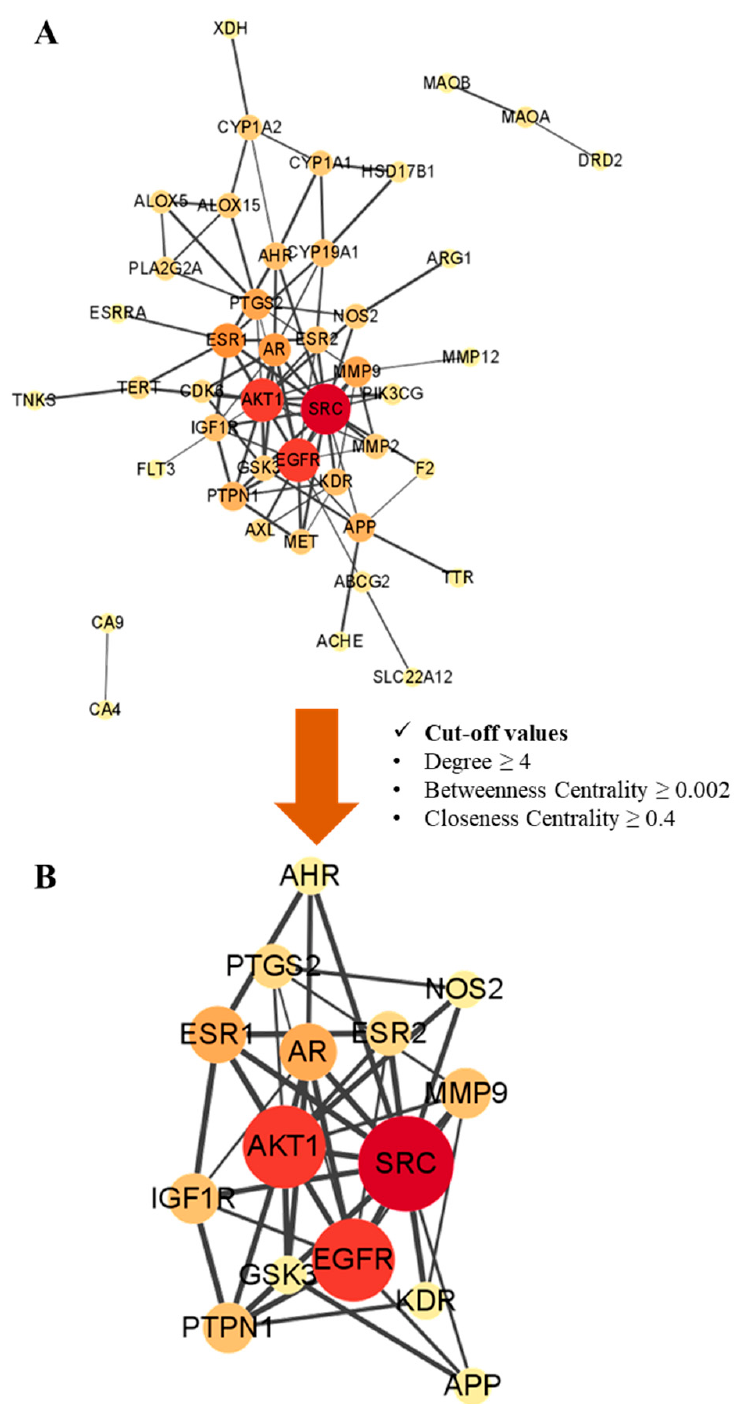
Figure 2. Protein–protein interaction (PPI) network of potential targets and key targets. ( A ) The PPI network of potential anti-obesity target genes of hispidulin. ( B ) The PPI network of the key anti-obesity target genes of hispidulin. The size and the red hue of a node represent its significance